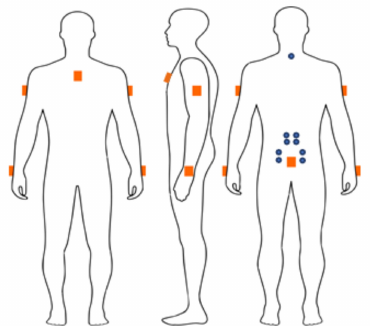
Figure 1. The positioning of the sEMG electrodes and IMMUs on the body. The surface electromyog- raphy (sEMG electrodes, blue circles) positioned on the longissimus thoracis muscles at L1 and the iliocostalis lumborum muscles at L2–L3 with a reference electrode placed at the processus spinosus of C7. The inertial magnetic measuring units (IMMUs, orange blocks) positioned on the sternum, upper, and lower (left and right) arms, and pelvis (sacrum) with a front (left), side (middle), and back view